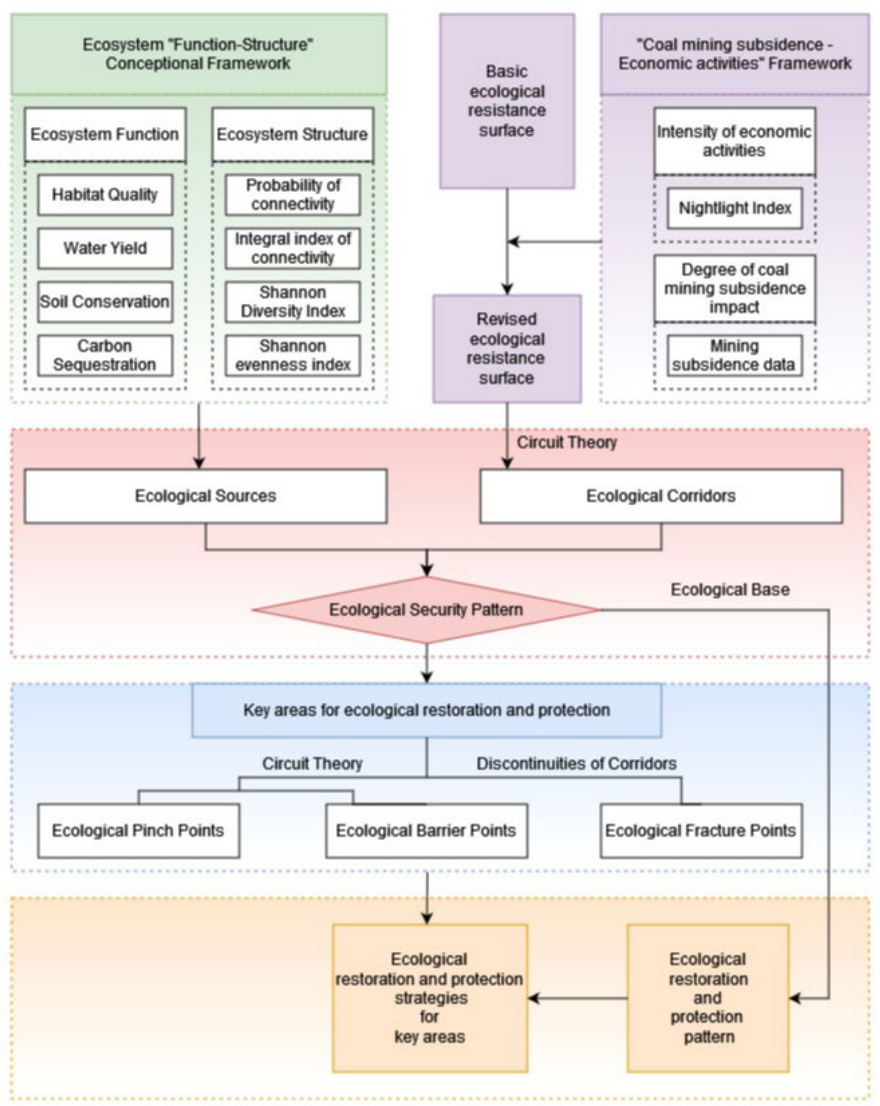
Figure 2. The research flow chart.